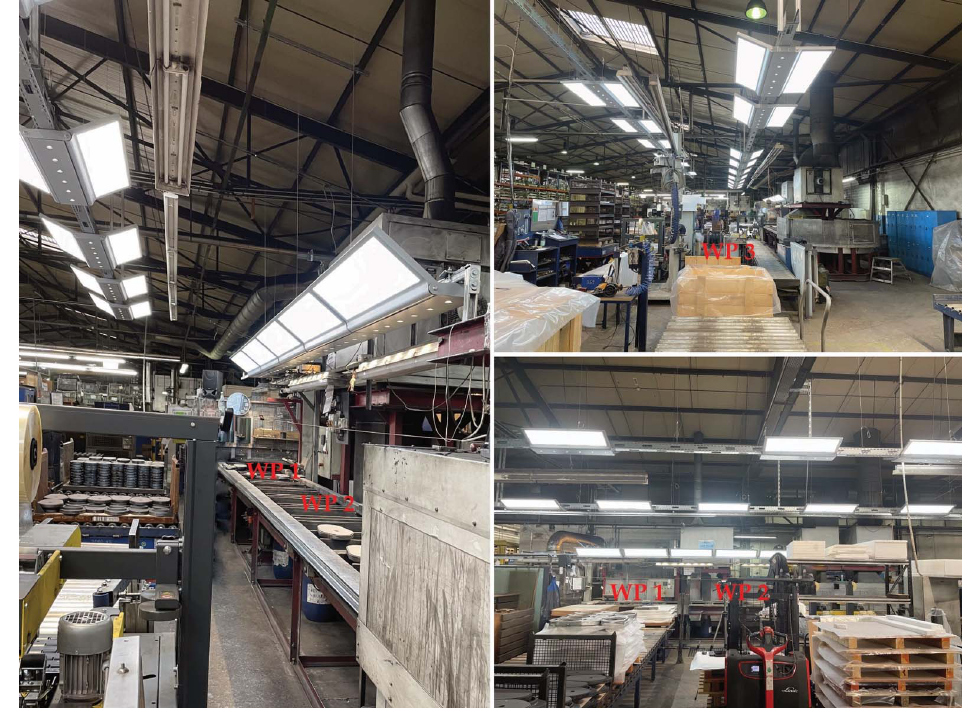
Figure 5. New lighting system after commissioning.